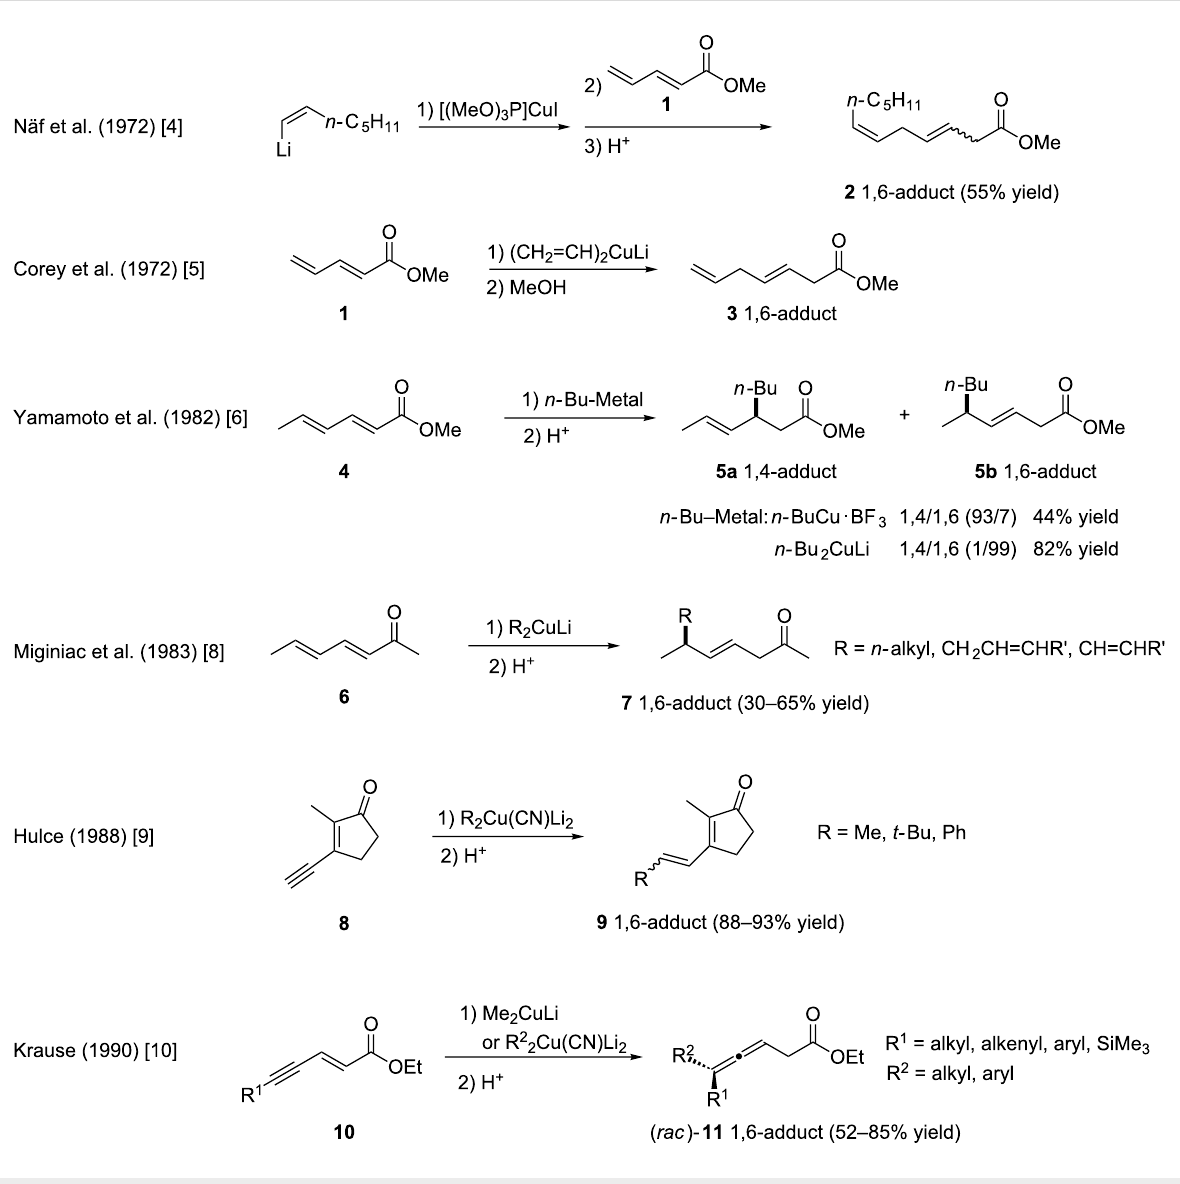
Figure 2: Early reports of conjugate addition of copper-based reagents to extended Michael acceptors.